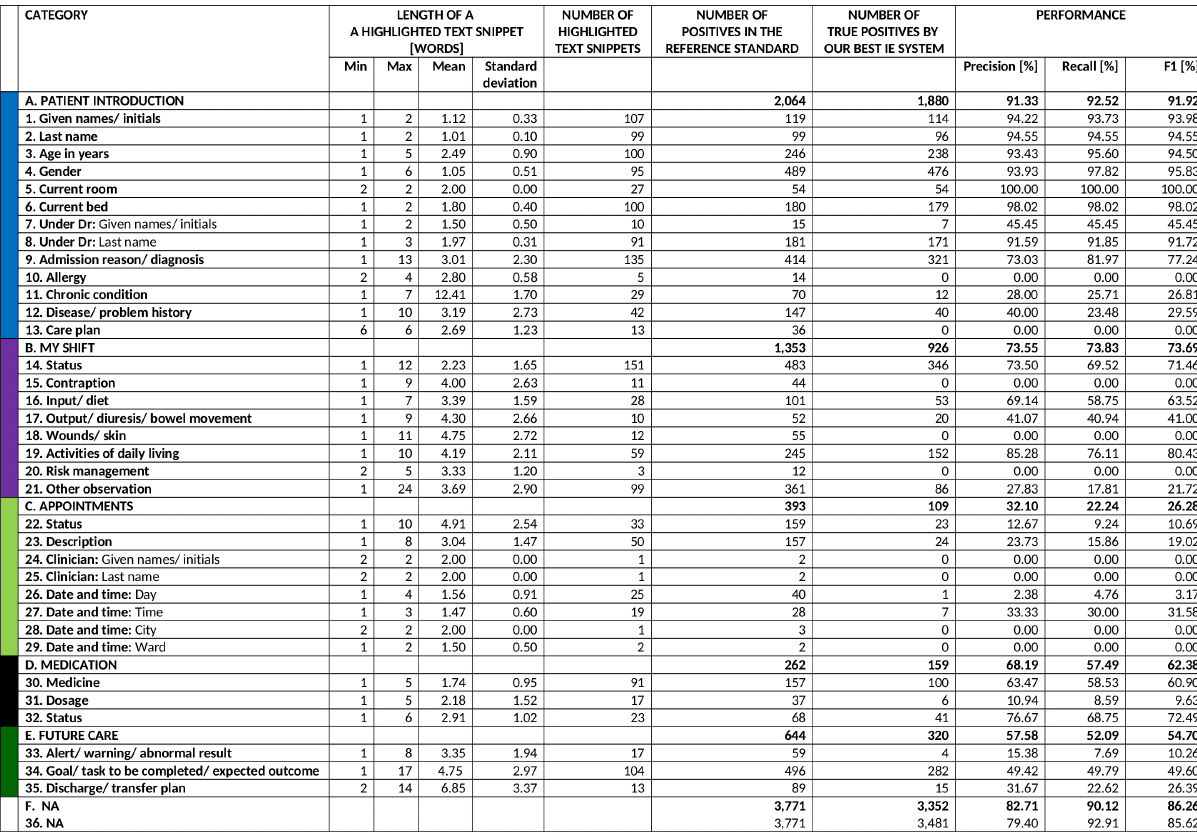
Figure 2. Descriptive statistics of text snippets highlighted by the registered nurse in the 101 written, structured documents used as a reference standard in information extraction together with the performance of our best information extraction system. RN: registered nurse; RS: reference standard; IE: information extraction; NA: not applicable; min: minimum; max: